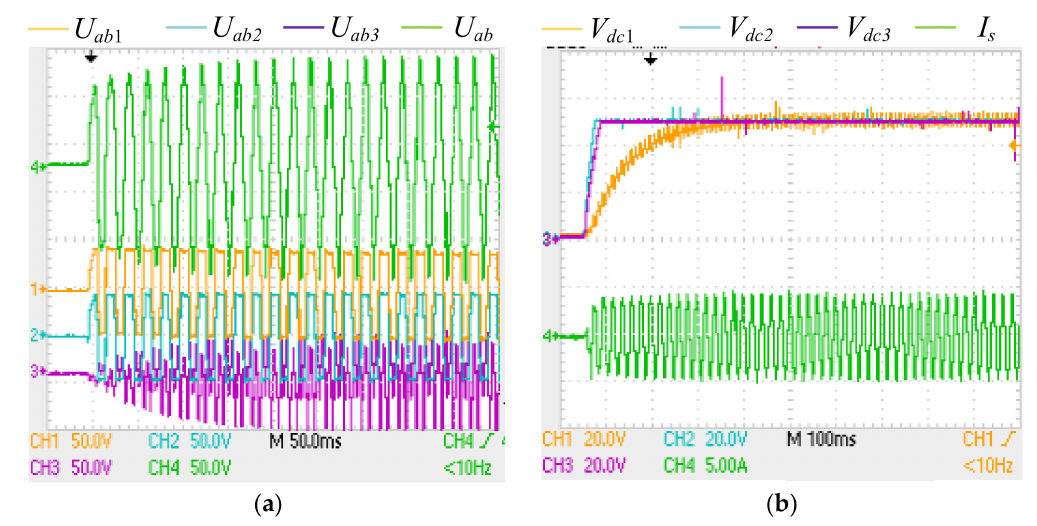
Figure 13. Experiment start with Module 1 su ff ering from an open-circuit fault. ( a ) Output voltages of 3LNPC-CC; ( b ) DC-side voltages and AC-side